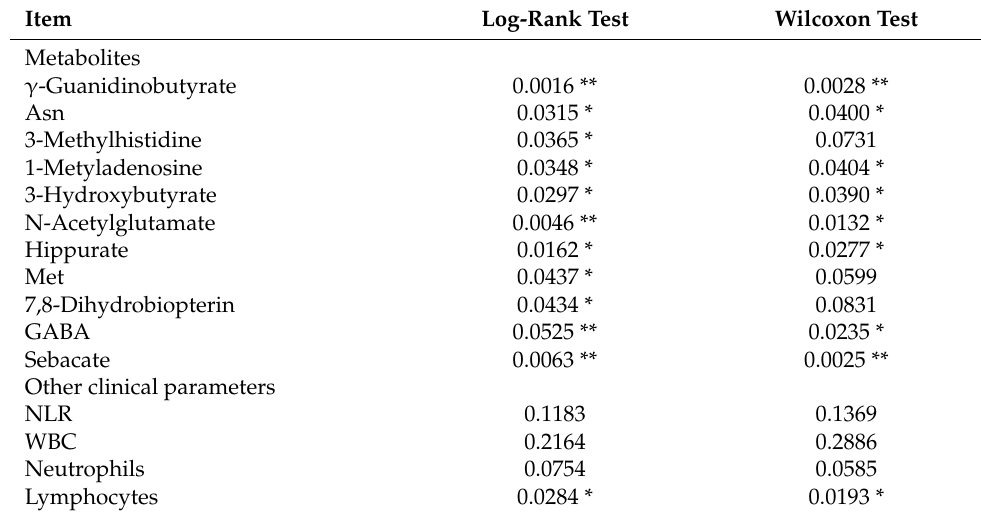
Table 6. p -values of DFS predictive factors.